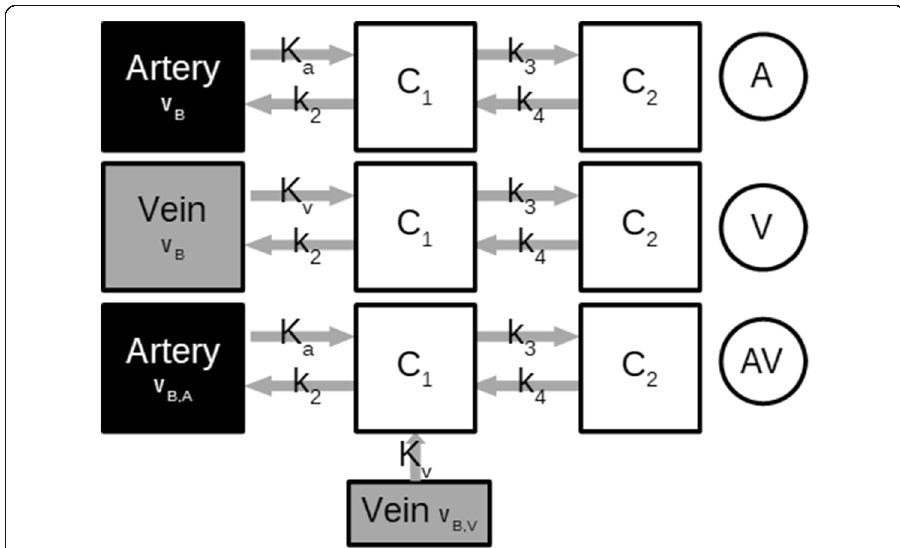
Fig. 2 Schematic presentation of all applied models with image-derived input functions (IDIF). Model A has an IDIF from the hepatic artery, model V from the portal vein, and model AV uses both IDIFs. v B , indicates blood